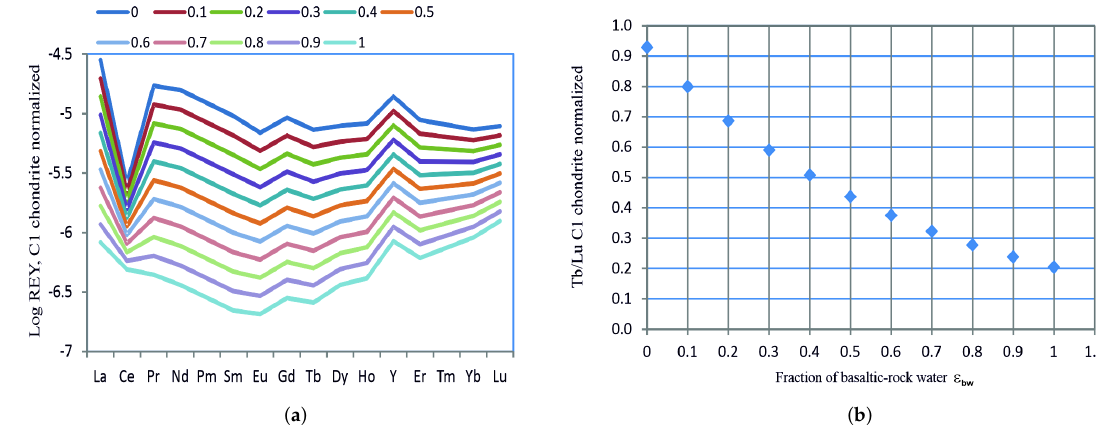
Figure 4. Variation of rare earth element distribution patterns in mixtures of basaltic-rock and limestone water. ( a ) Estimates of mixing of basaltic-rock-(1) and limestone water (0); ( b ) resulting C1 chondrite normalized Tb/Lu values as a function of ε bw . REY data are taken from [15] and are normalized to C1 chondrite to get smooth curves. The average of Ein Dan and Ein Banyas in Mount Hermon Massif are used as pure limestone water; as basaltic-rock water the analysis of Mukheibeh 2/2013 is used. Data are taken from